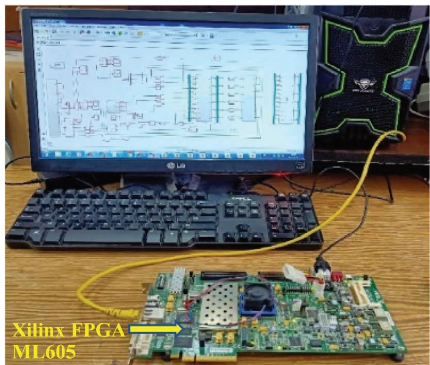
Figure 12: Experimental system setup.